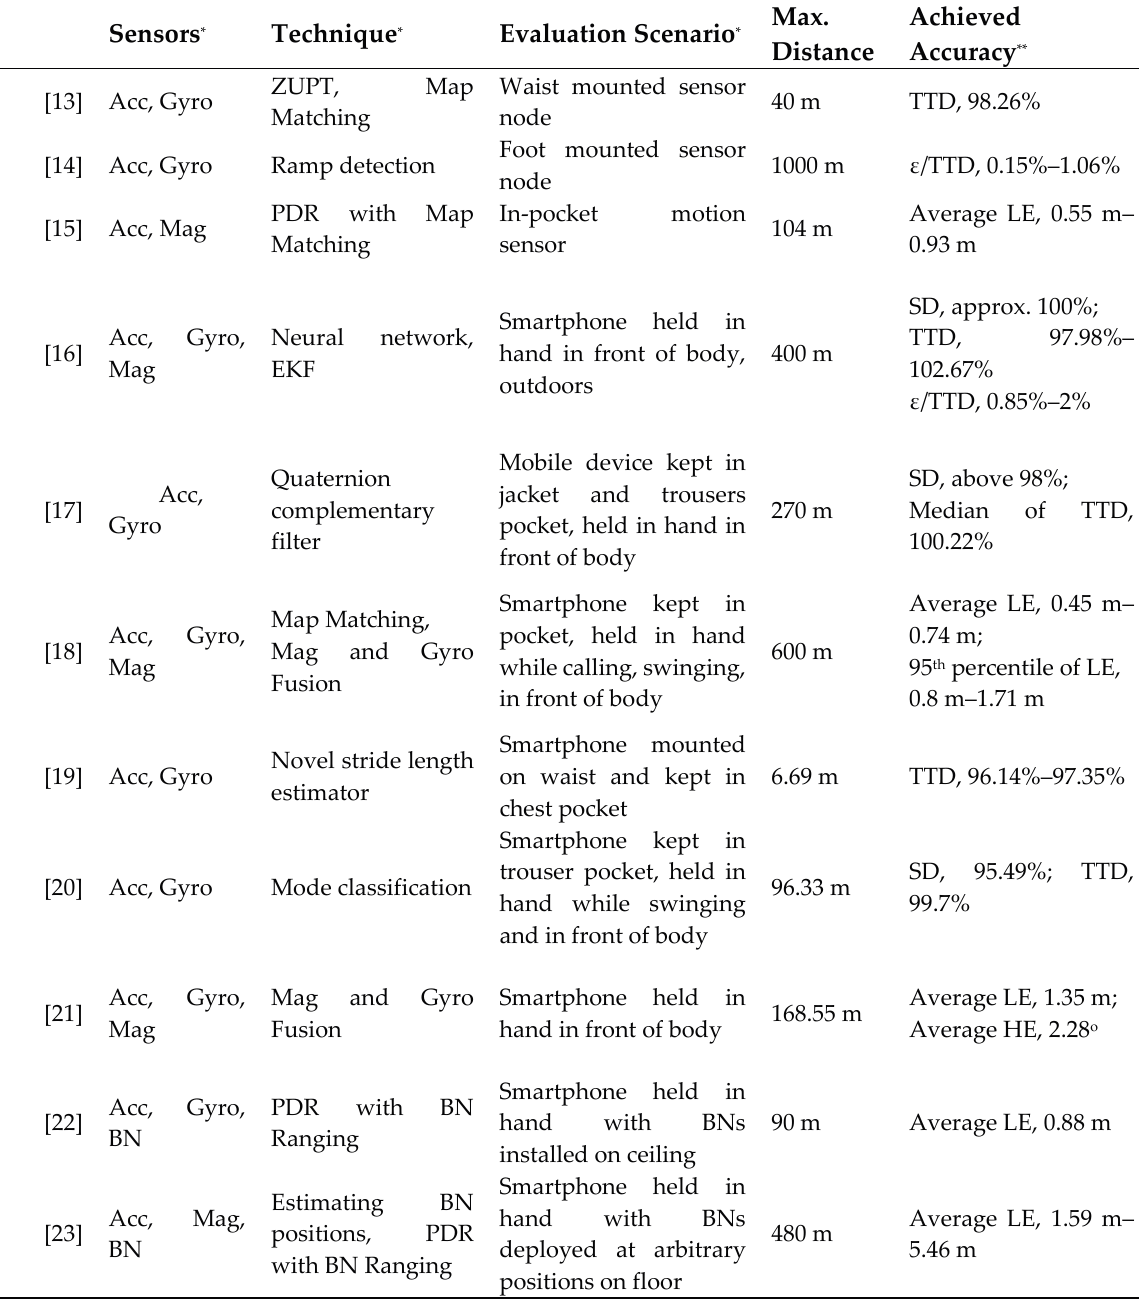
Table 1. Summary of related works with PDR